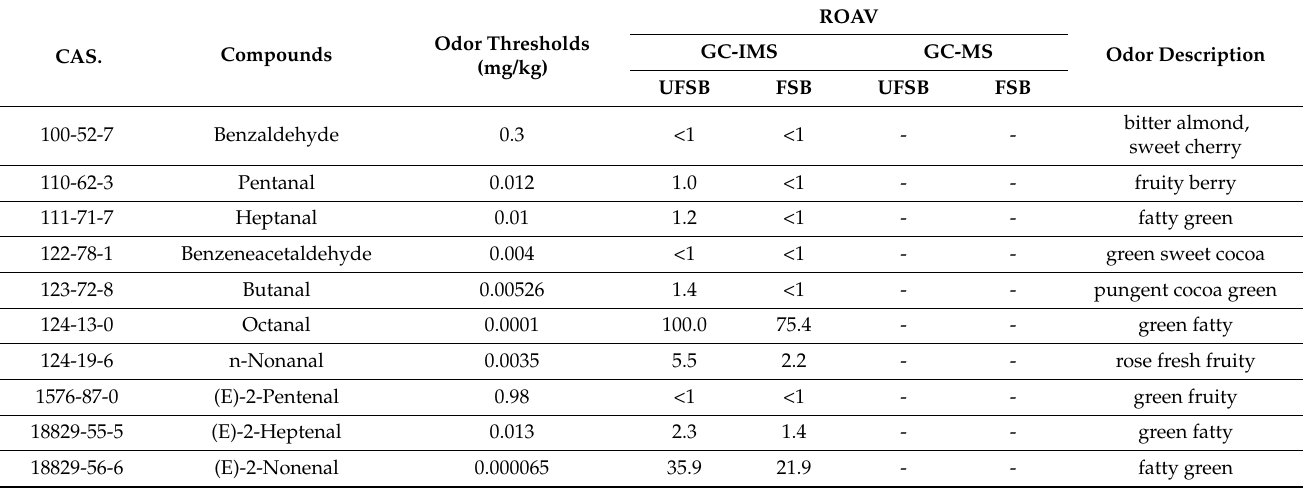
Table 4. Relative odor activity values (ROAV) and odor description of volatile compounds of soy